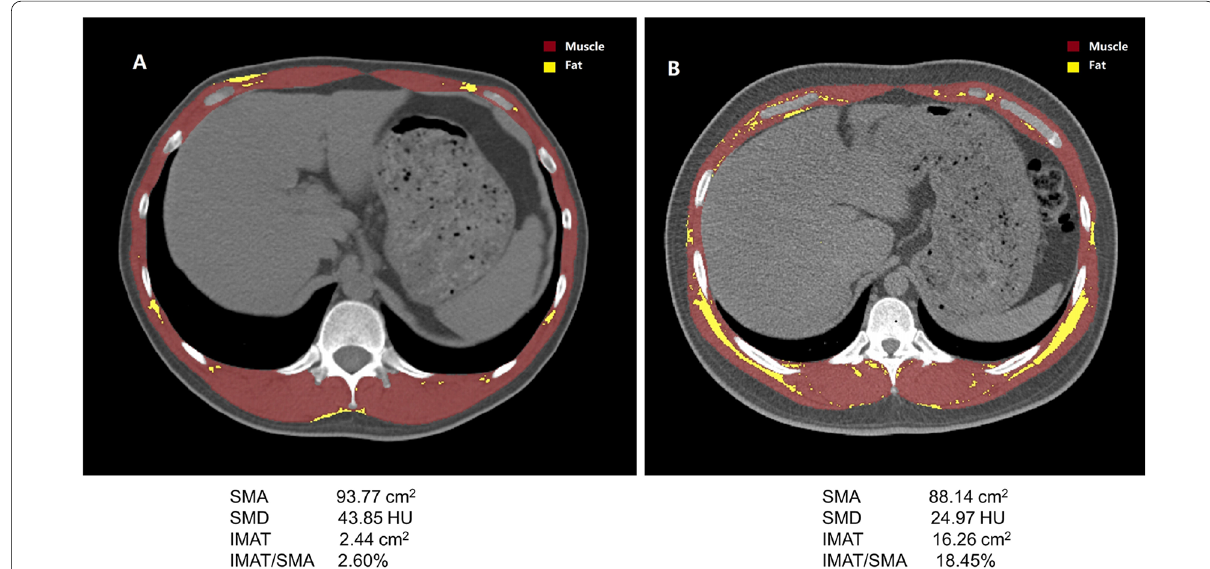
Fig. 1 Cross-sectional CT images at the T12 level used for the quantification of muscle mass and fat mass in a 39-year-old man ( A ) and a 62-year-old woman ( B